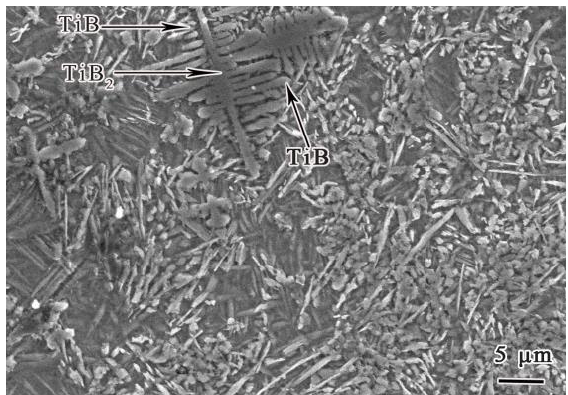
Figure 6. The dendritic-like morphology in the cladding layer.